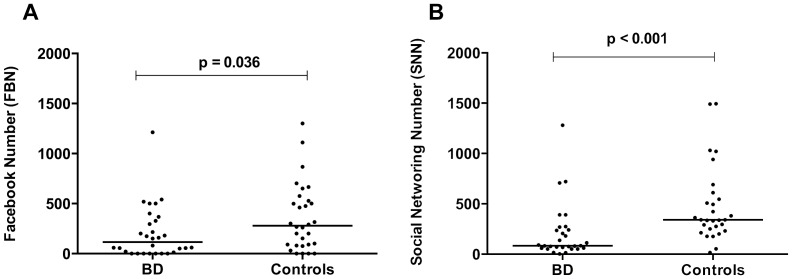
Social Networking Online and Offline in BD patients.
A. The Facebook number of friends (FBN) in patients and controls. B. The social networking number or lifetime total number of friends (SNN) in patients and controls.